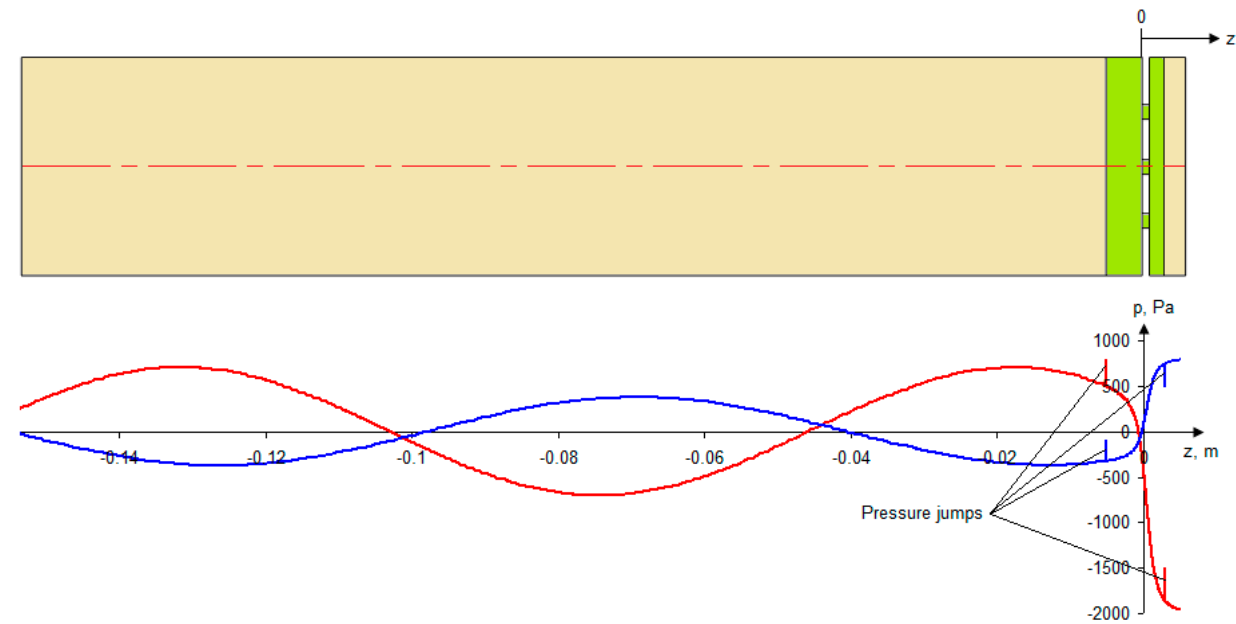
Figure 5. Distribution of acoustic pressure along the symmetry axis of the geometric model at a frequency of 3000 Hz: the red line is the real part; the blue line is the imaginary part; coordinate z = 0 is on the resonator surface.